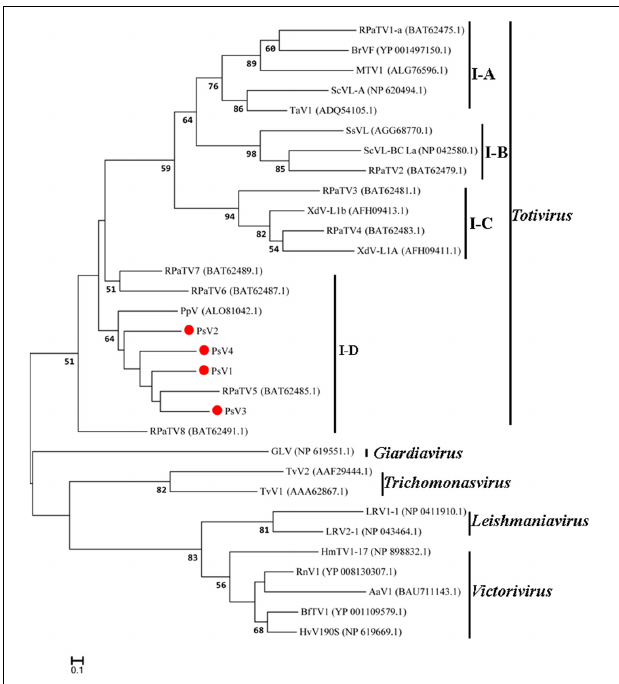
FIGURE 6 | Phylogenetic analysis based on the deduced amino acid sequences of putative CPs using the maximum likelihood (ML) method with 1,000 bootstrap replicates. The scale bar represents a genetic distance of 0.1 amino acid substitutions per site. Red circles indicate the novel mycoviruses PsVs in the present study.